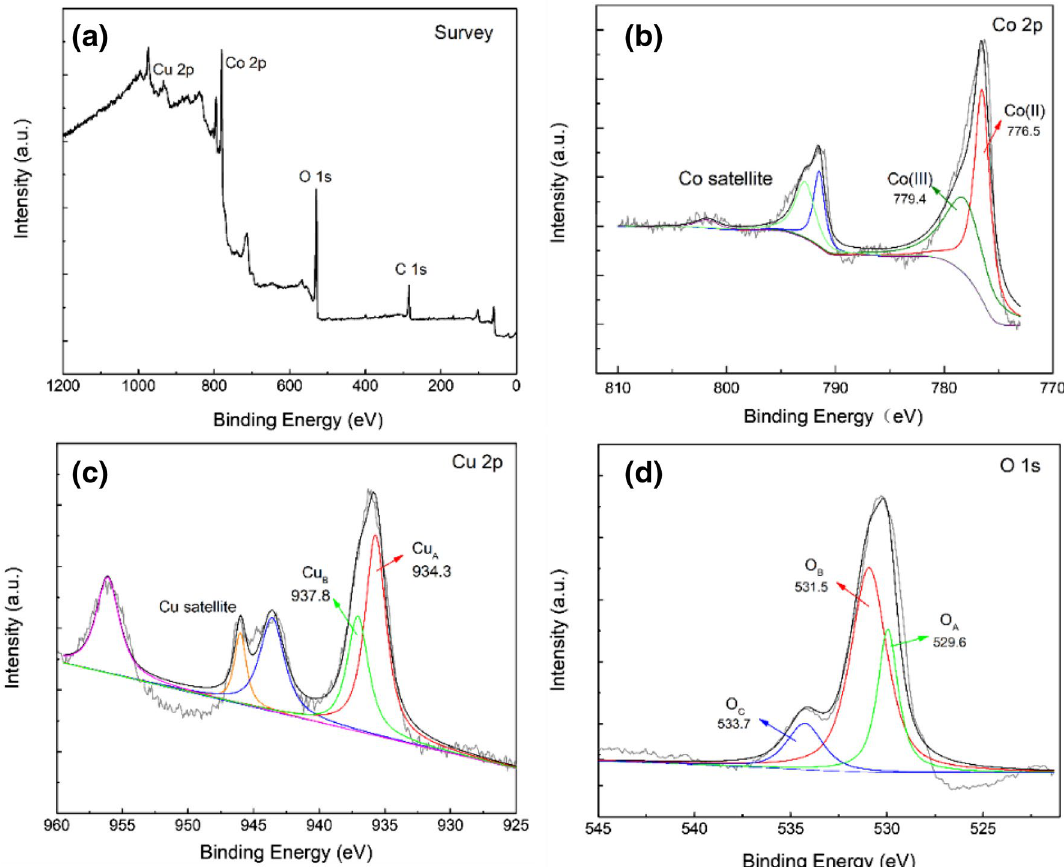
Fig. 4 XPS analysis for as-prepared Cu x Co 3− x O 4 (with Cu:Co = 1:2): a the general survey, b Co 2p, c Cu 2p and d O 1s